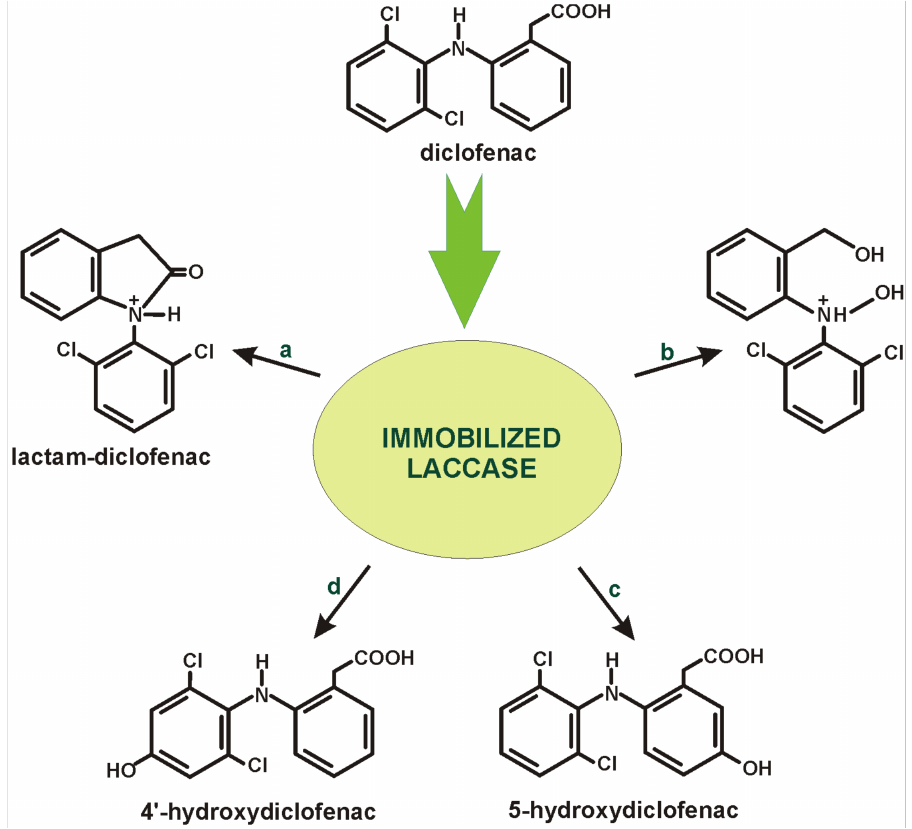
Figure 3. Products of diclofenac biodegradation in the immobilised system. Small letters indicate the type of carrier, where ( a , b ) electrospun nanofibers, ( c ) carbon nanotubes, and ( d ) sodium alginate- silicon dioxide-polyvinyl alcohol beads